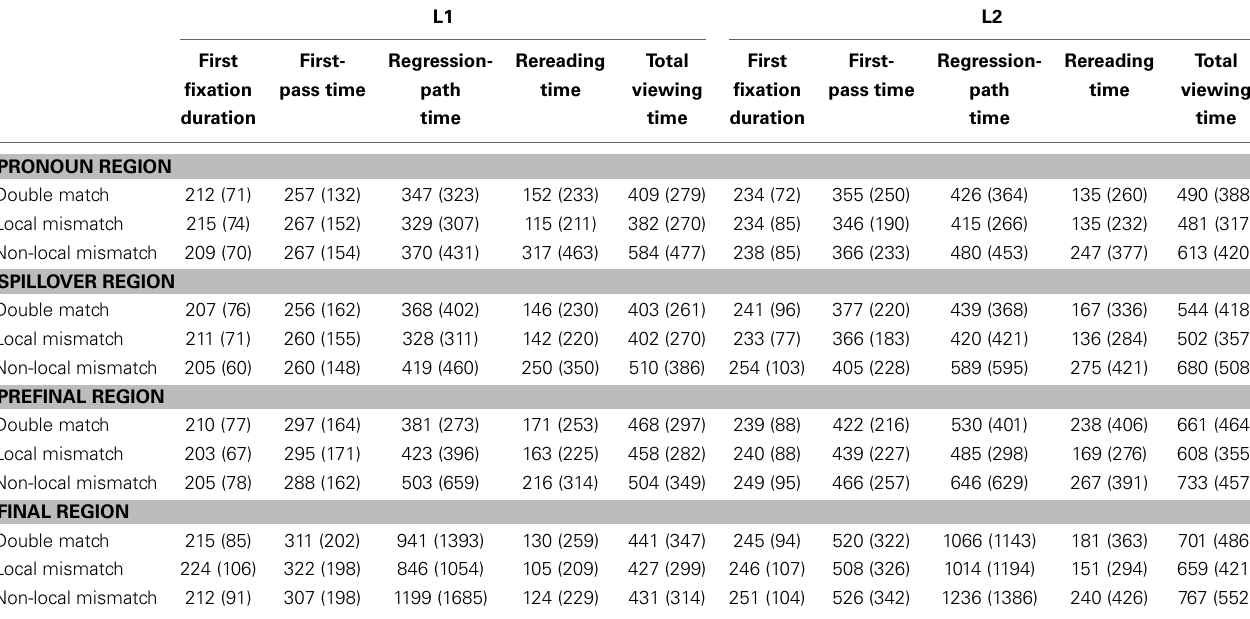
Table 1 | Means (standard deviations in parentheses) for five eye-movement measures at four areas of interest in Experiment 2, for each participant